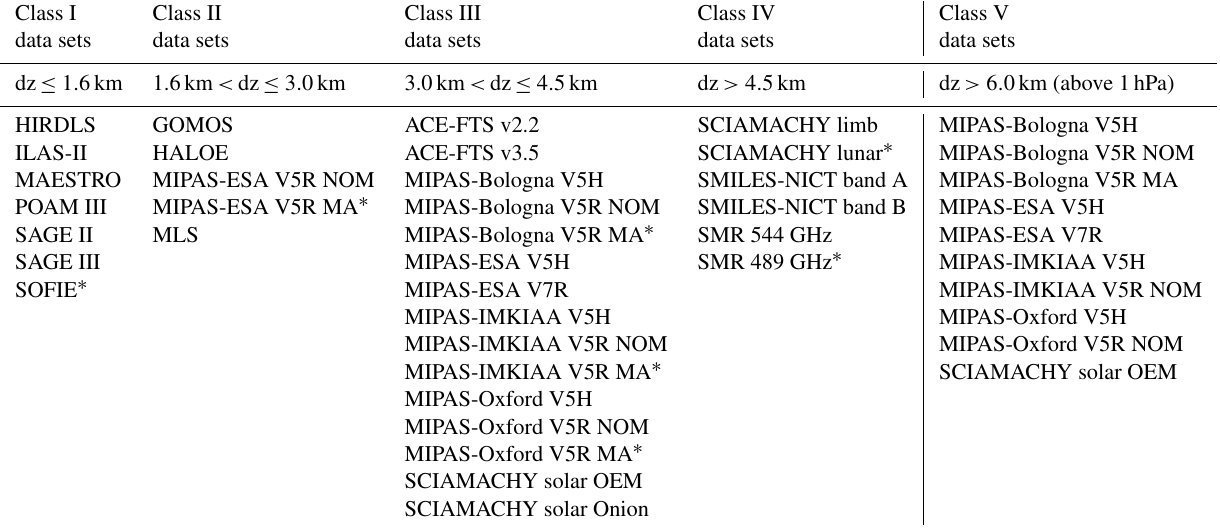
Table 2. The convolution classes. Based on these differences in the vertical resolution were considered in the comparisons of the data sets. The first four classes consider resolution differences around the hygropause, while class V addresses differences at the stratopause and lower mesosphere. Data sets marked by a asterisk have a limited coverage of the hygropause. The consideration of differences in the vertical resolution in comparisons to these data sets may be not necessary but has been made just in